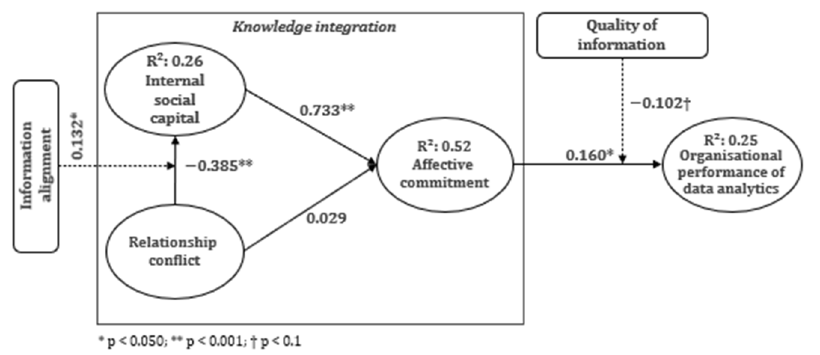
Figure 2. Empirical